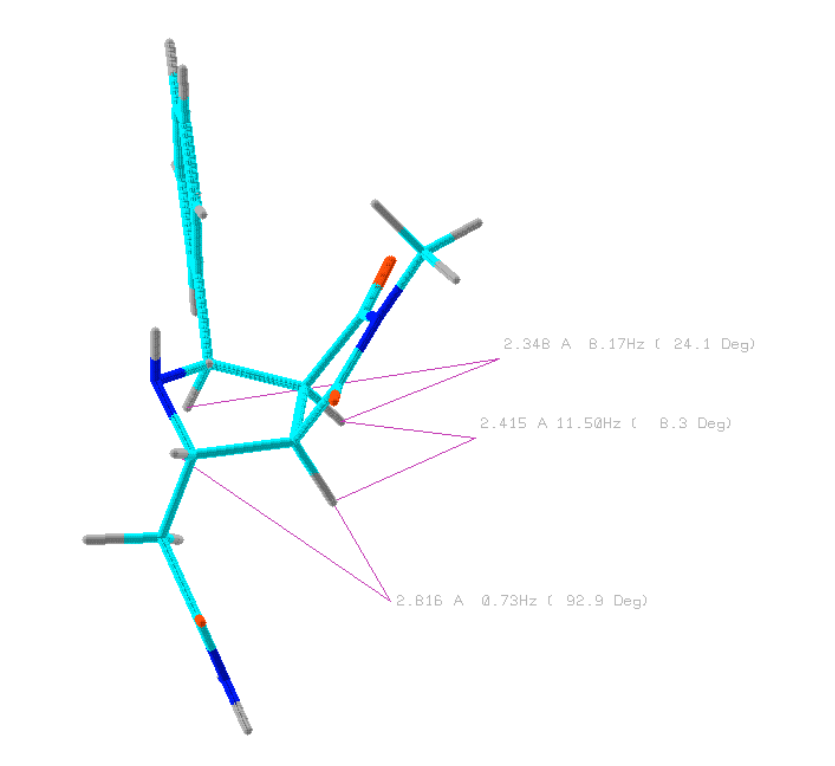
Figure 1. Molecular modeling structure of (1S*, 3R*, 3aS*, 6aR*)-2-(5-Methyl-4,6-